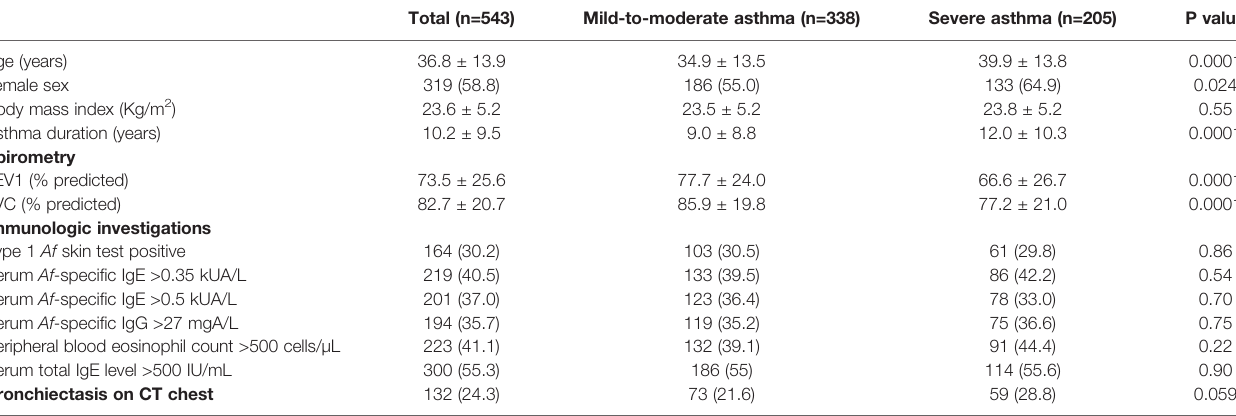
TABLE 2 | Select baseline characteristics of the study